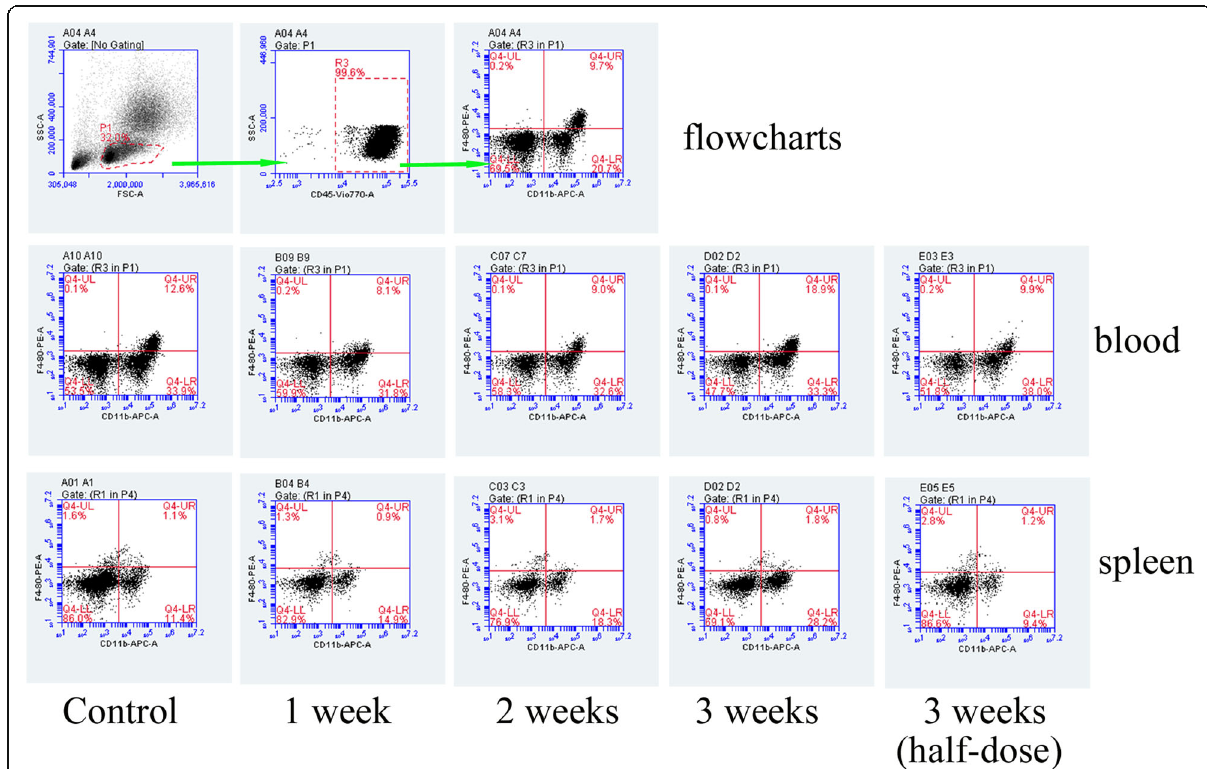
Fig. 3 Representative flow cytometry results of macrophage cells in blood and spleen. The macrophage cells were shown as CD45 + CD11b + F4/ 80+ population (Q4-UR quadrant in each row). The percentage indicates CD45 + CD11b + F4/80+ cells in CD45+ cells in the monocyte and